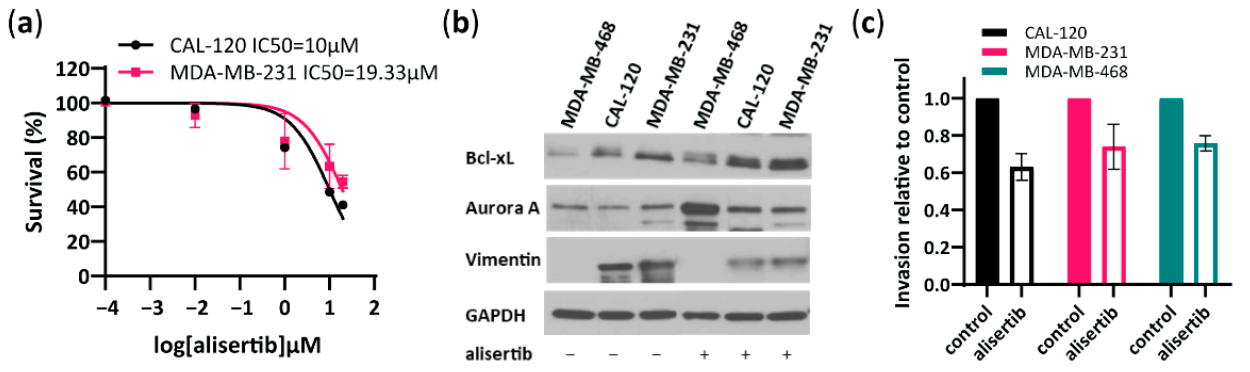
Figure 3. Aurora A inhibitor, alisertib reduces the invasive properties of basal B breast cancer cells. ( a ) Concentration-dependent inhibition of cell viability performed in basal B cells to determine the IC50 of Aurora A inhibitor alisertib, as assessed by an MTT assay 72 h after treatment; ( b ) Western blot analysis of Aurora A, Bcl-xL and vimentin in MDA-MB-468, CAL-120 and MDA-MB-231 cells before and after treatment with alisertib (10 µM in MDA-MB-468 cells and 20 µM in CAL-120 and MDA-MB-231 cells, treated for 72 h). GAPDH was used as loading control; ( c ) Analysis of invasion properties of basal A and basal B cells treated with alisertib (10 µM in MDA-MB-468 cells and 20 µM in CAL-120 and MDA-MB-231 cells, treated for 72 h) relative to cells without chemoat- tractant. The data represent the mean of two biological replicates ± SEM.